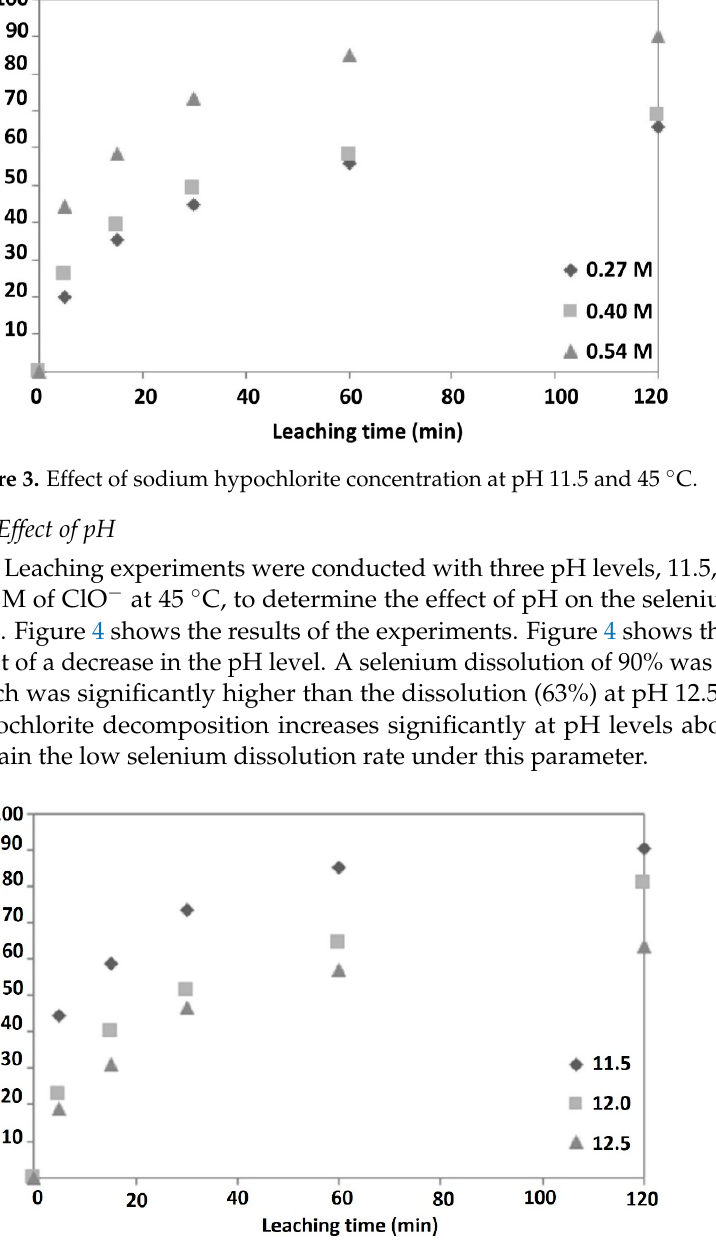
Figure 4. Effect of the pH level on leaching selenium, with 0.54 M of ClO − at 45 °C.